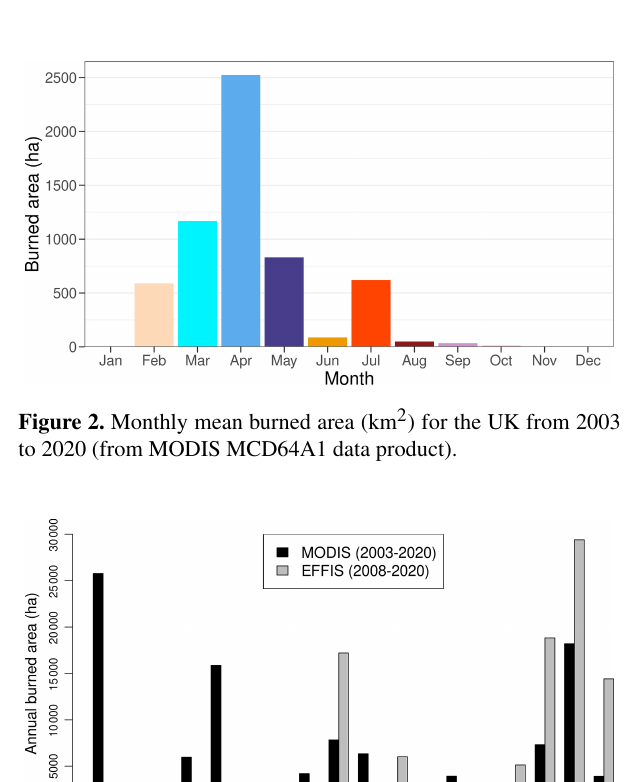
Figure 1. Monthly burned area (km 2 ) for the UK from 2003 to 2020 from MODIS MCD64A1 data.